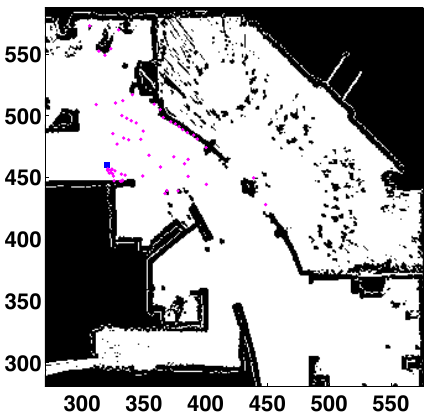
Figure 9. Example of contaminated laser scan with 55% contamination. All units in cells. Laser readings in purple. Robot’s location (320 , 460 , 10) in the blue